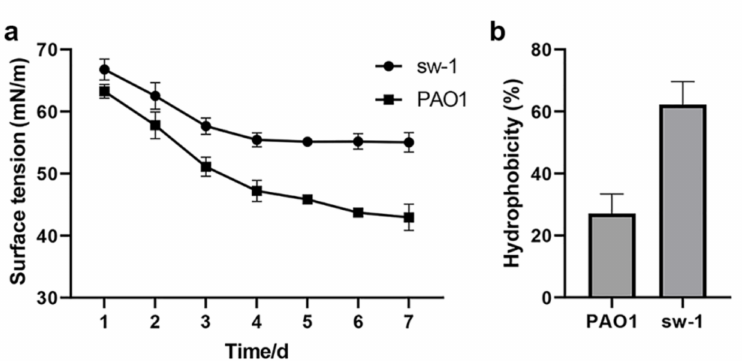
Figure 7. The difference between A. pittii sw-1 and P. aeruginosa PAO1 in terms of fermented liquid surface tension ( a ) and cell surface hydrophobicity ( b ). The determination of surface tension was conducted using a tensiometer. The measurement was performed once a day. The cell surface hydrophobicity was detected by assessing cell adherence to n